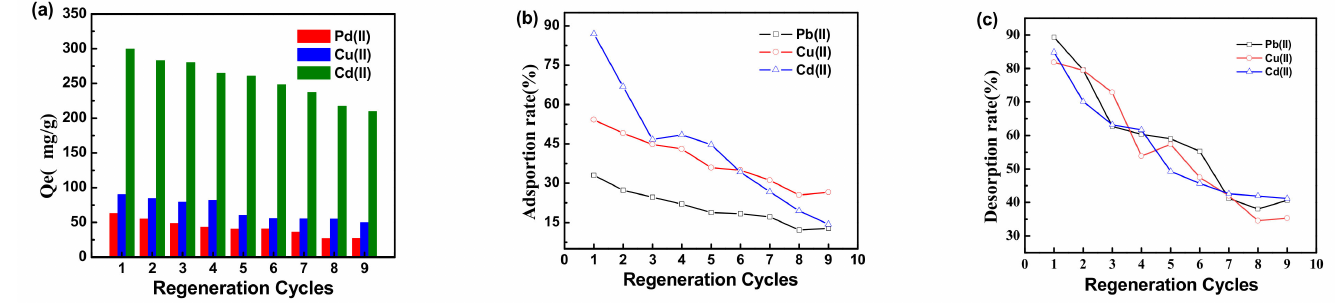
Figure 7. Adsorption capacity of the XMPC on metal ions during regeneration cycles, ( a ) adsorption capacity, ( b ) adsorption rate, and ( c ) desorption rate in regeneration cycles.